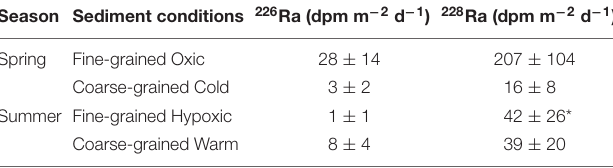
TABLE 5 | Summary of 226 Ra and 228 Ra sediment fluxes in Long Island